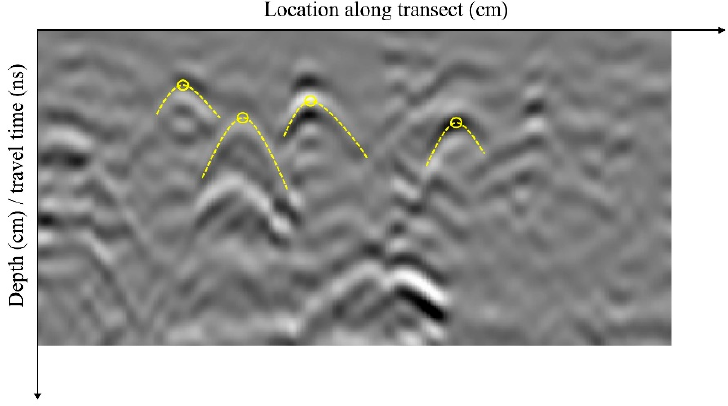
Figure 4. Detection and localisation of rhizomes using identification of by identifying hyperbolic reflections in a processed radar image. The yellow circles indicate the locations of the rhizomes as the vertices of the hyperbolic reflections.